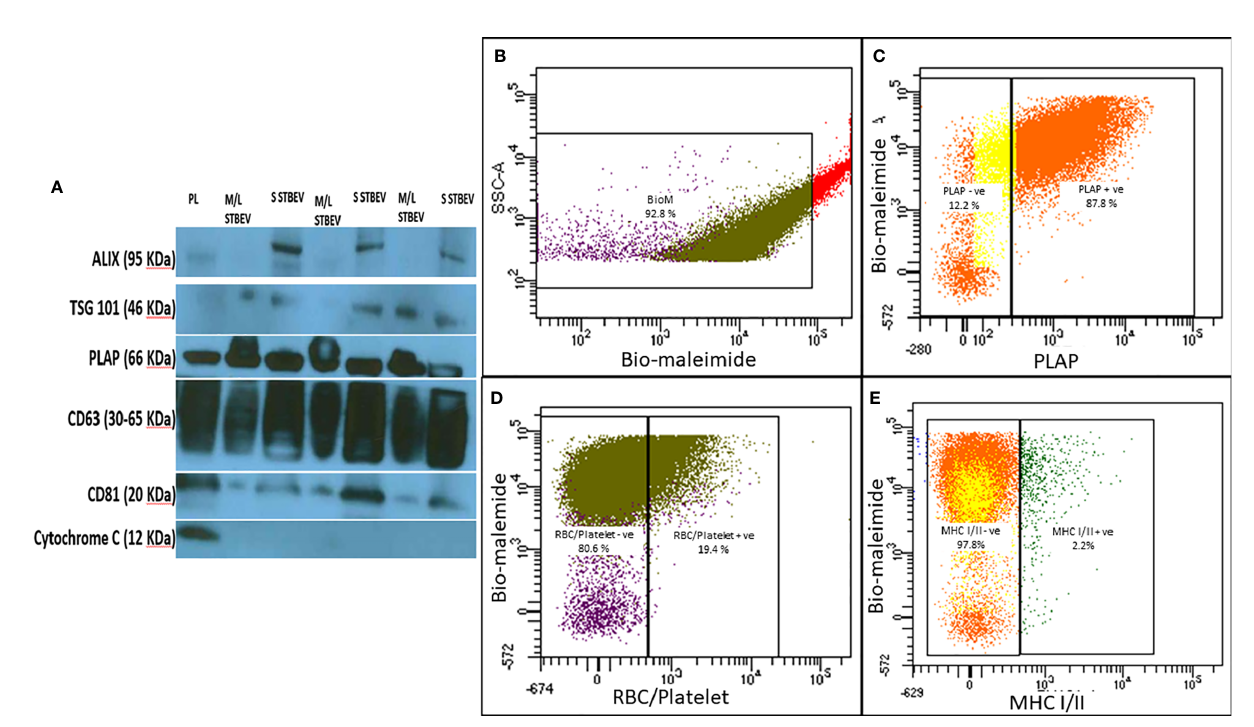
FIGURE 1 | (A) Representative Western blot image of placenta lysate (PL), medium/large STBEVs (n=3) and small STBEVs (n=3) showing expression of extracellular vesicle markers (ALIX, TSG101, CD63 and CD81), syncytiotrophoblast origin marker (PLAP) and negative expression of cytochrome (C) . (B – E) are representative fl ow cytometry analysis graphs of medium/large STBEVs derived from the placentae. (B) the per cent of vesicles in the medium/large STBEVs enriched sample fraction (based on the per cent of bio-maleimide positive events), (C) the per cent of PLAP positive extracellular vesicles, (D) the per cent of MHC I/II negative extracellular vesicles. In contrast, (E) shows the per cent of platelet and endothelial cells derived vesicles in our